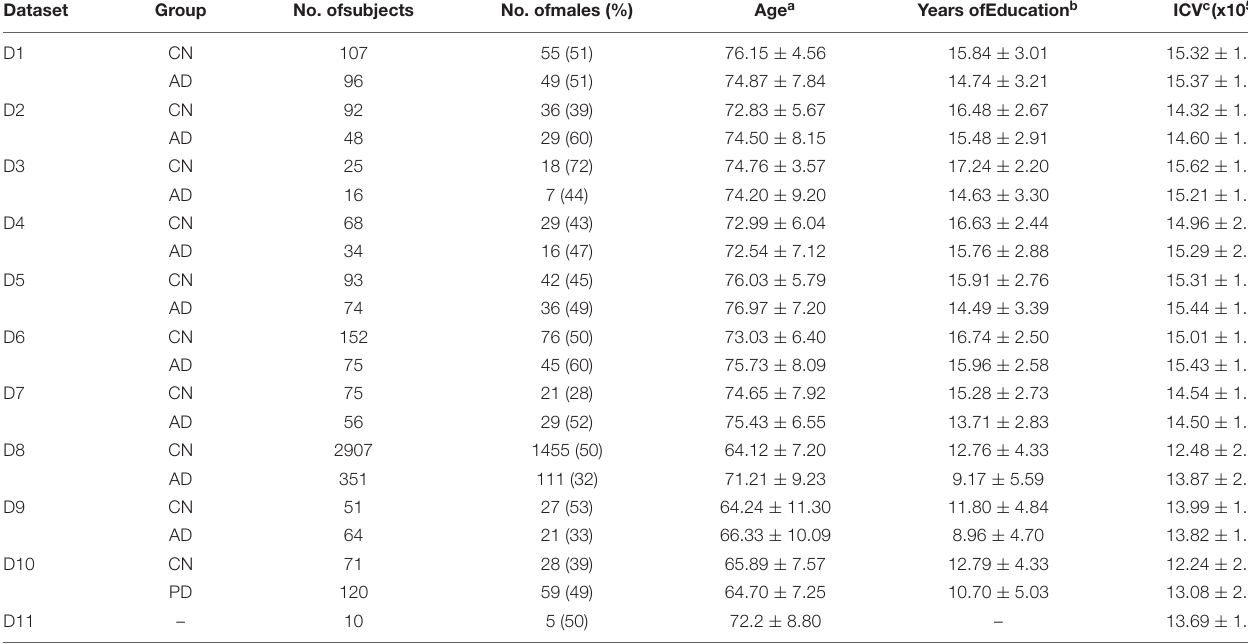
TABLE 2 | Description of the subjects of each dataset set. Dataset